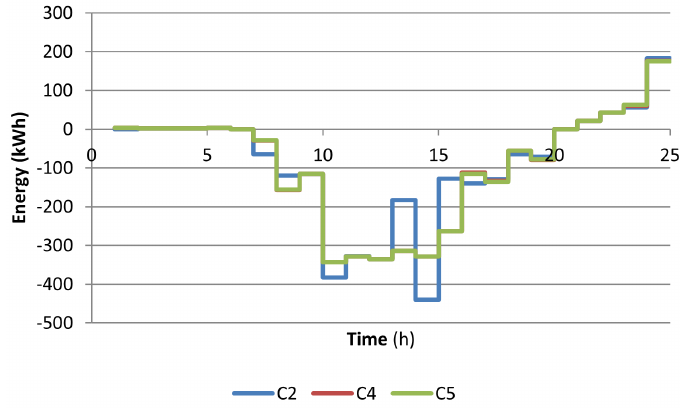
Figure 4. The DAM schedule for summer in C2, C4 and C5.